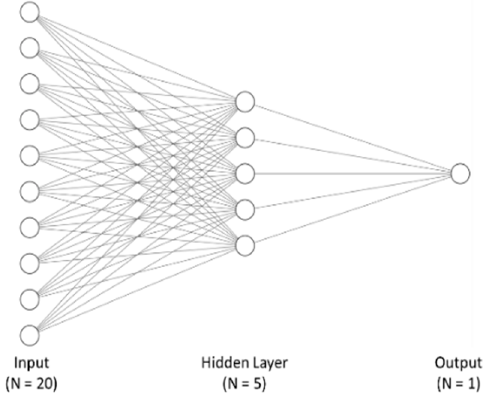
Figure 2. A diagram of the feedforward neural network structure that is used in this